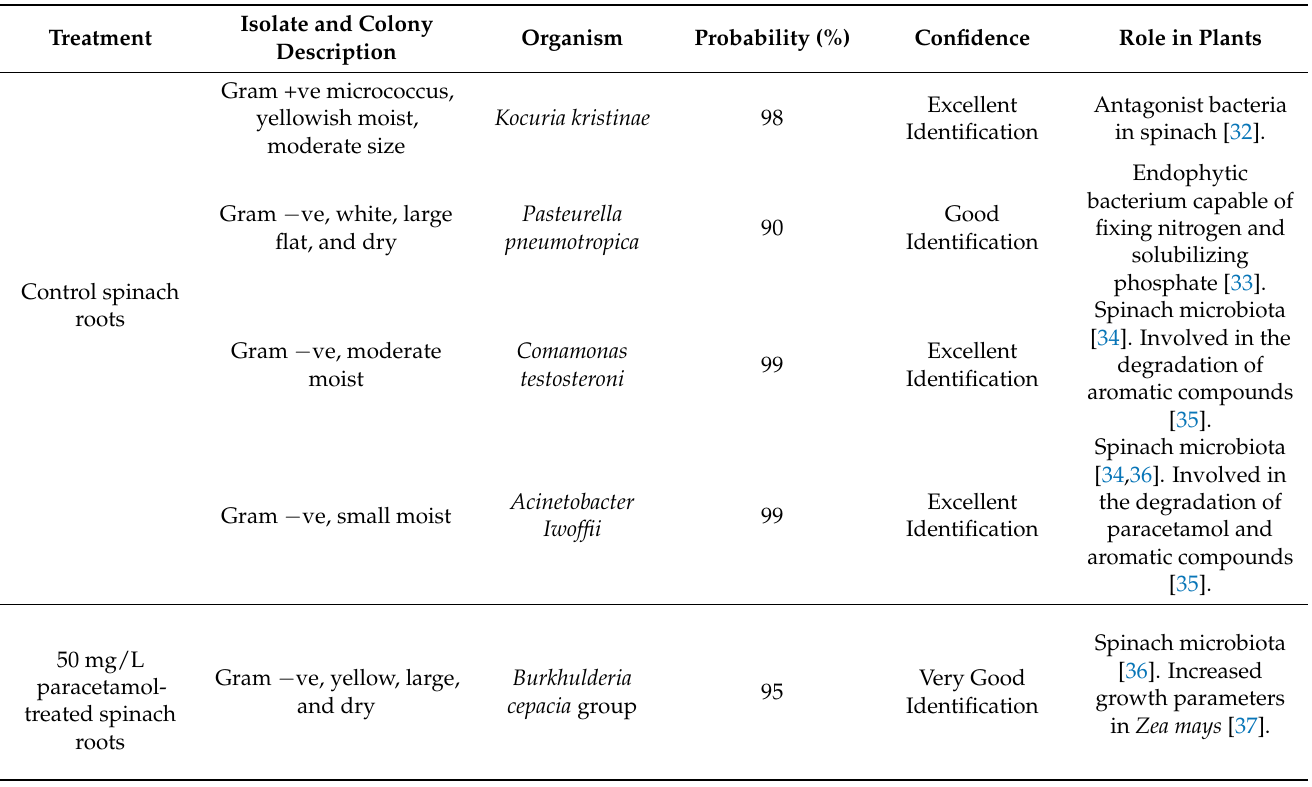
Table 3. Microbial consortium of spinach roots treated with paracetamol for eight days.